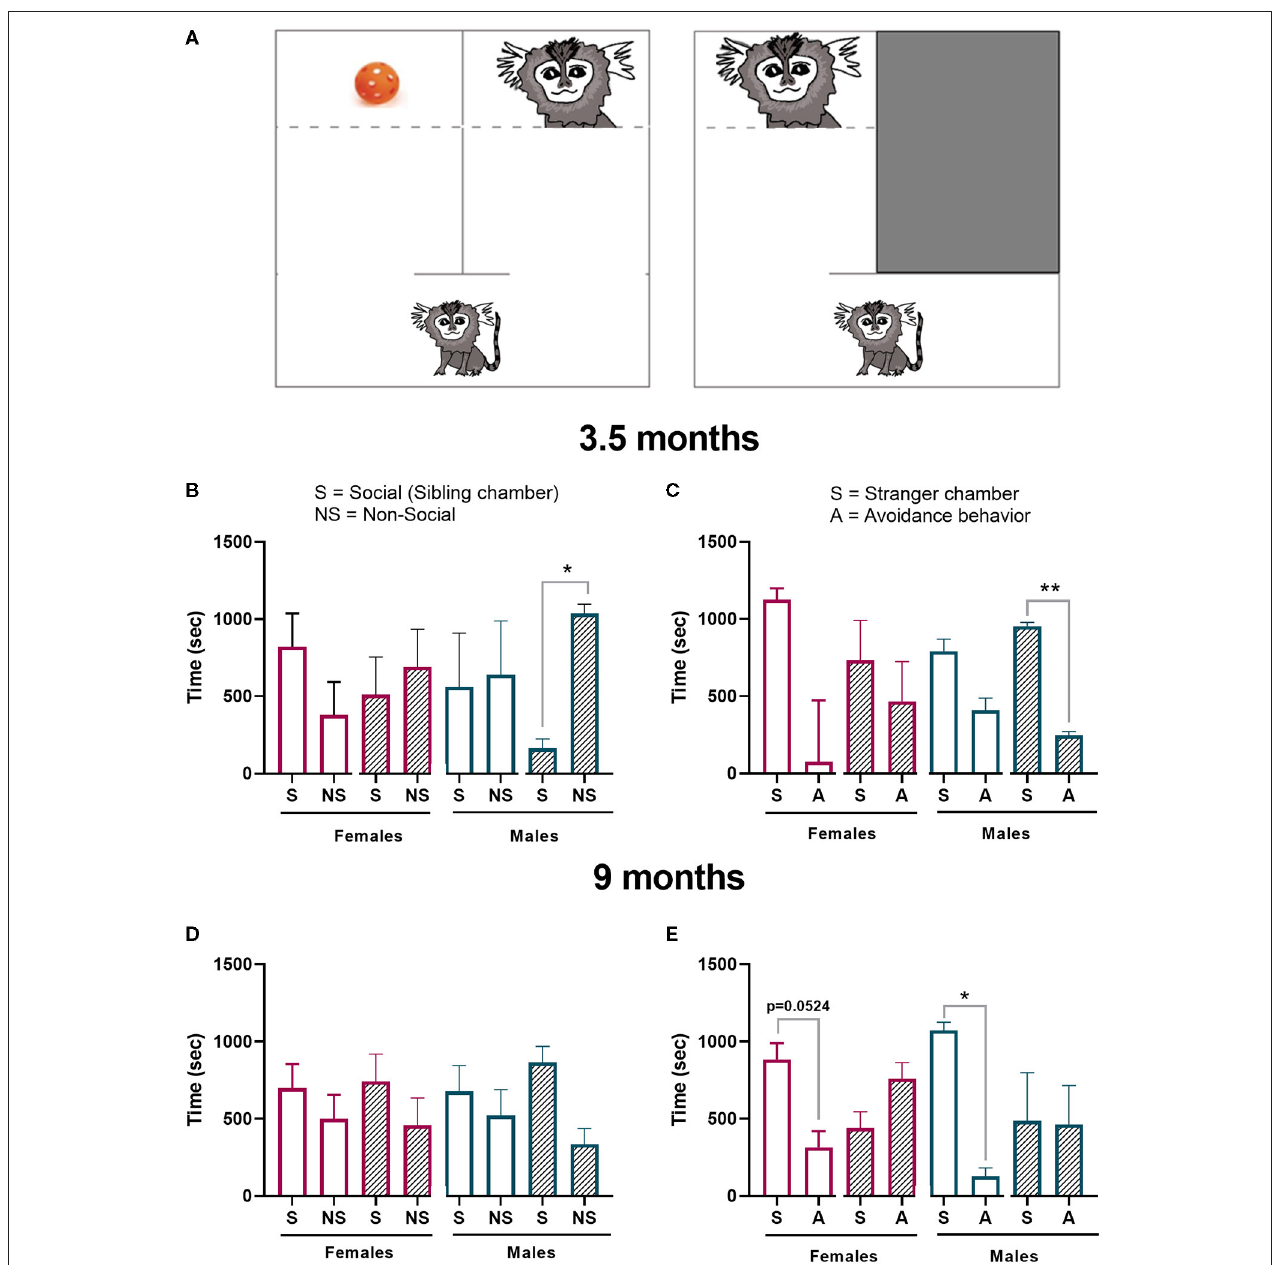
FIGURE 9 | Sociability test. (A) Schematic of the test chamber. The first part of the test (social preference) the animal had the option to interact with a sibling (S) or a toy (NS). The second part of the test (social novelty) the animal had the option to interact with a stranger conspecific (S) or hide (A) . Offspring performance in the (B) sociability preference test or the (C) novelty preference test 3.5 months of age was measured. Offspring performance was again tested at 9 months in the (D) sociability preference test and (E) novelty preference test. Control female n = 6, Poly IC females n = 4, Control males n = 3, Poly IC males n = 3. Data are expressed as median ± interquartile range and analyzed with Wilcoxon matched-pairs signed rank test. Normally distributed data are expressed as mean ± SEM and analyzed with paired T -test. Significant differences are indicated by * p < 0.05 and ** p <